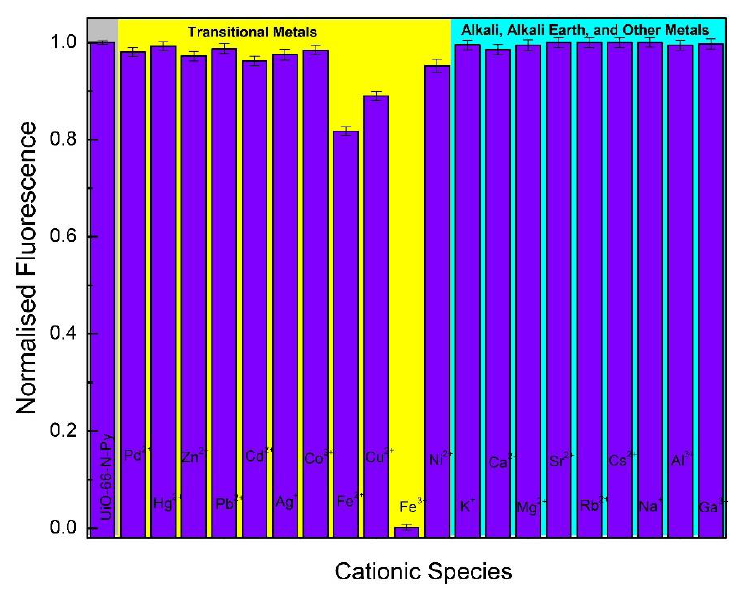
Figure 6. Change in the normalized fluorescence emission of UiO-66-N-Py in water upon the addition of 200 μL of different metal cations (10 −2 M).